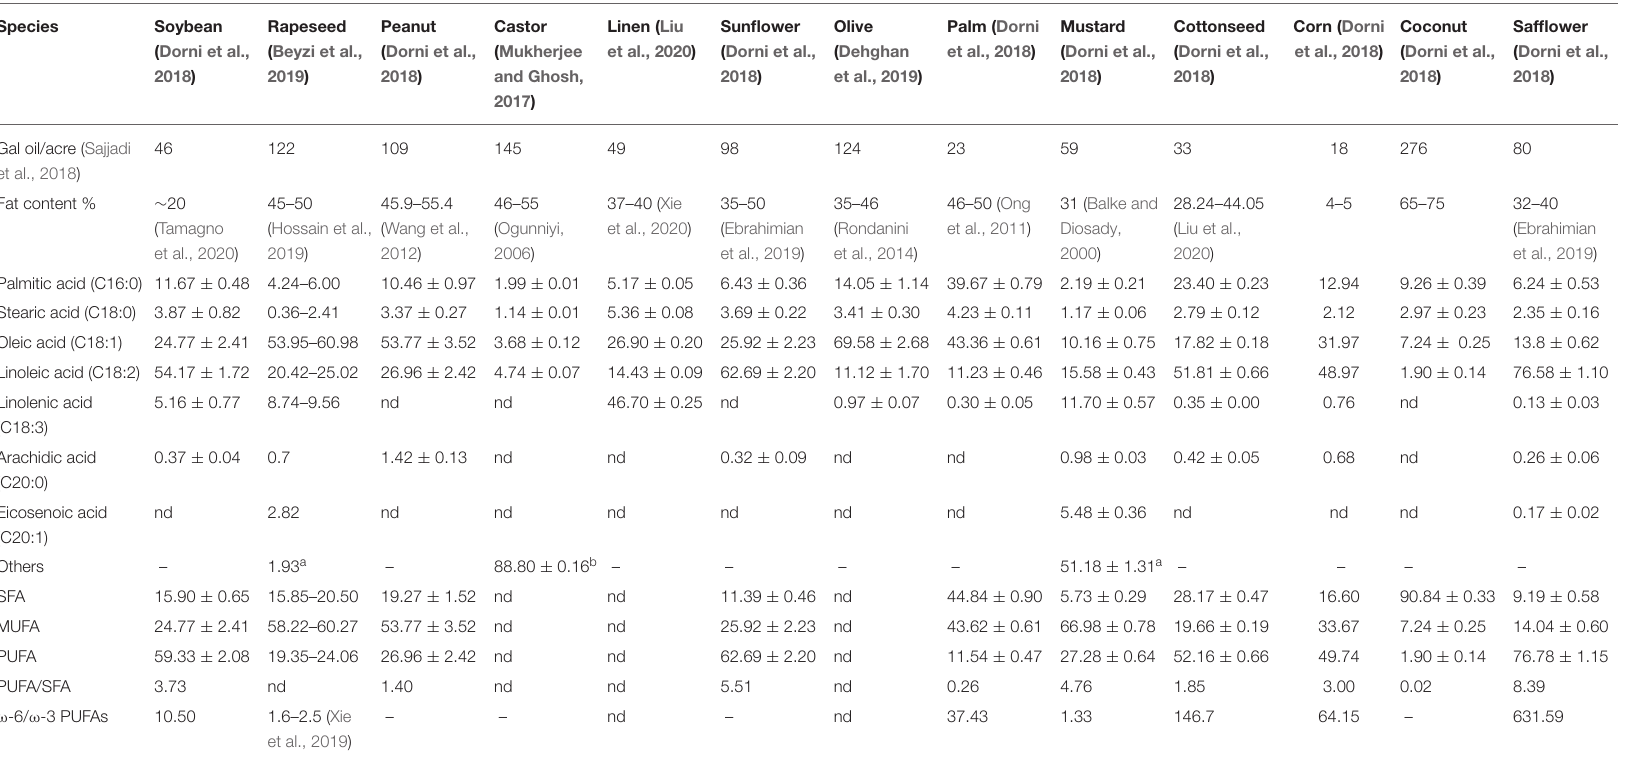
a Erucic acid (C22:1); b Ricinoleic acid (C20:0(OH)); nd, not determine. SFA, saturated fatty acids; MUFA, monounsaturated fatty acids; PUFA, polyunsaturated fatty